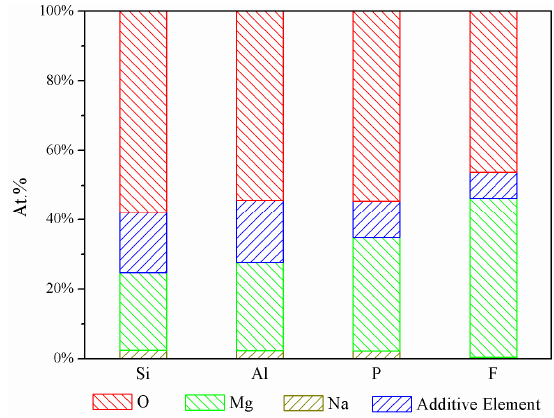
Figure 5. Chemical compositions of PEO-coated AZ31 magnesium alloy. Energy-dispersive spectroscopy (EDS) spectrum of framed region in Figure 2a,b and Figure 3a,b.